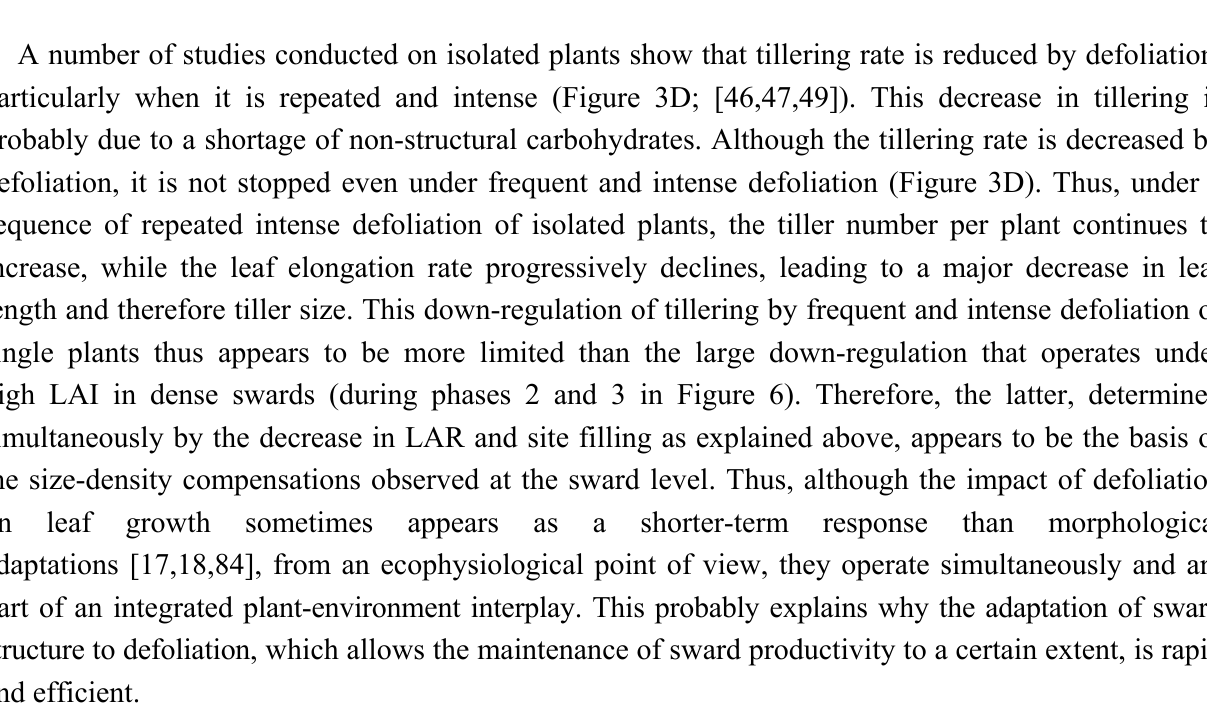
Figure 6. Time trends in tiller density ( ● ), leaf area index ( ■ , LAI), and leaf appearance rate ( ▲ , LAR) for a tall fescue sward following a cut (at day 0). Adapted from